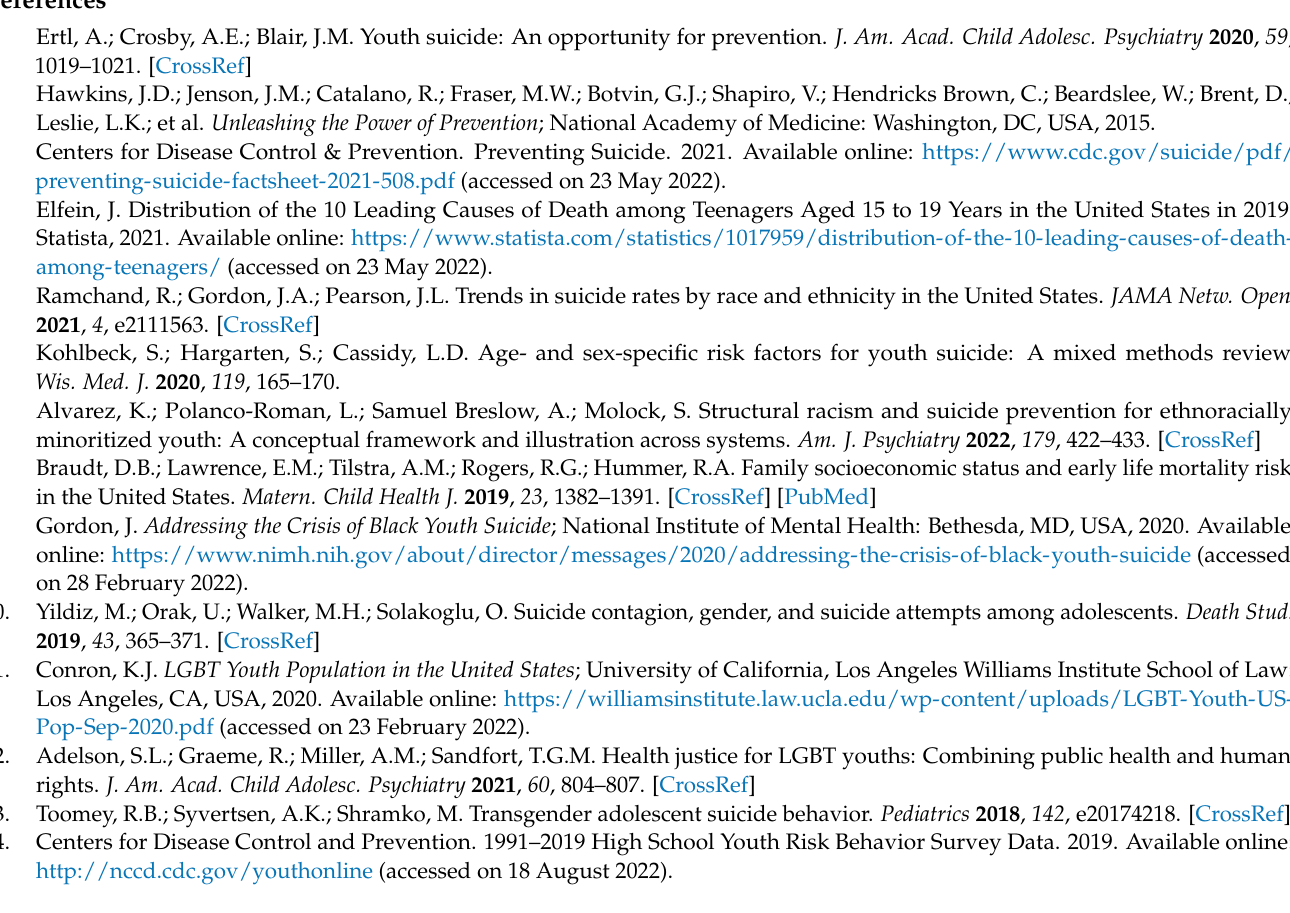
Figure A1. Queer Prevention of Youth Suicidality Model (Queer-PRYSM).